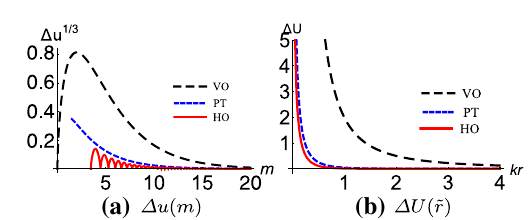
Fig. 5 Plot of the correction term Δ U ( kr ) for case HO. The dashed black line is the result of (cid:17) 10000